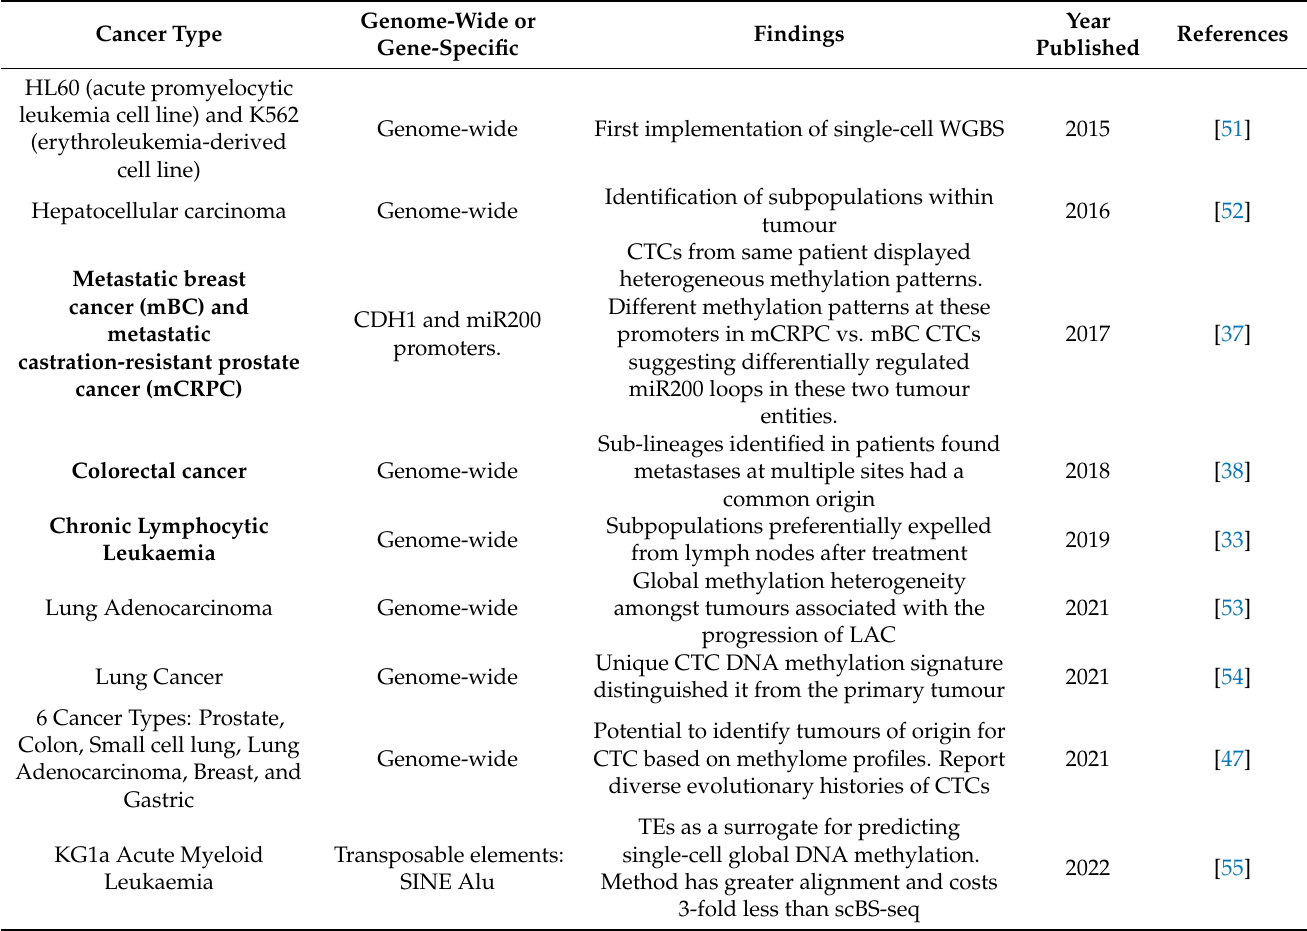
Table 1. Examples of single-cell methylome sequencing experiments in